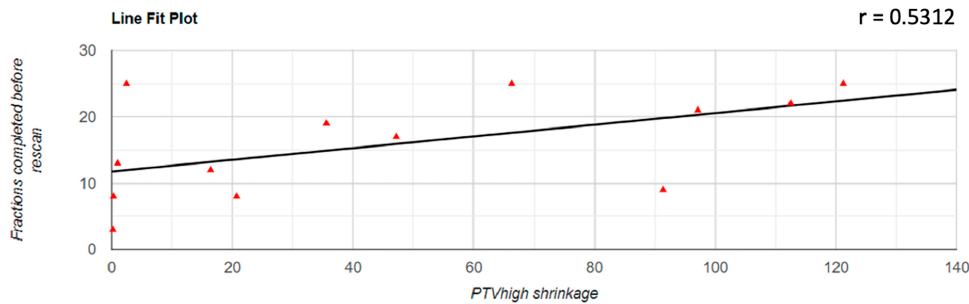
Figure 5. Graphical representation of the PTVhigh reduction in correlation with the number of fractions completed before replanning. 3.2. Parotid Glands Shrinkage Significant changes were found in the size of both the ipsilateral and the contralateral parotid. The ipsilateral parotid gland was not delineated in two cases because the tumor had a massive invasion of the gland; therefore, it could not be considered as OAR. For the ipsilateral parotid, the average decrease in volume was 3.75 cm 3 (14.43%) ( p = 0.067), and